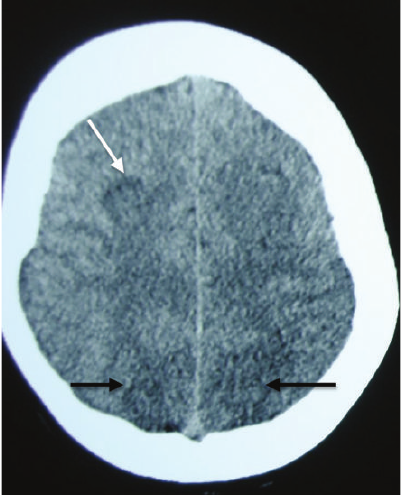
Figure 1: Cranial computerized tomography indicating discreet hypodensity on both occipital lobes (black arrows) and a hypodense lesion on the right parietal lobe (white arrow).